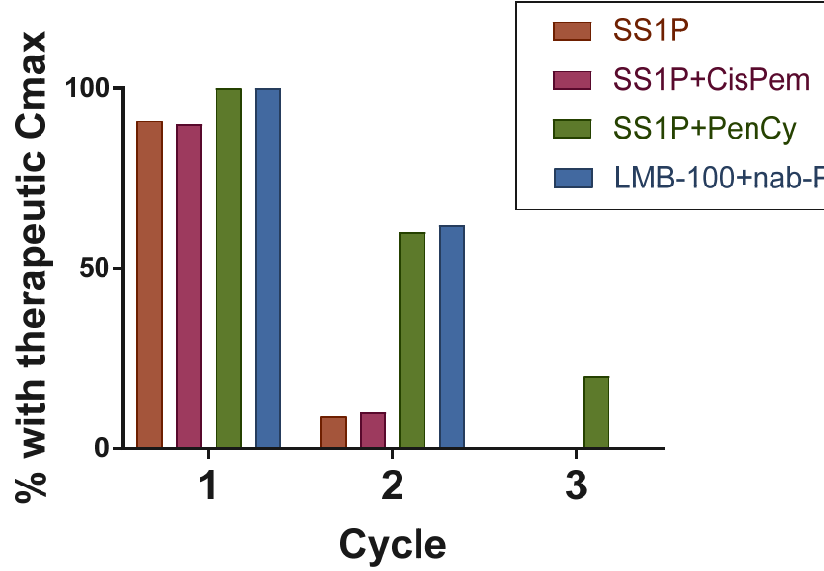
Figure 2. Rates of therapeutic drug levels by treatment cycle for each clinical trial of MSLN-targeted iToxs.